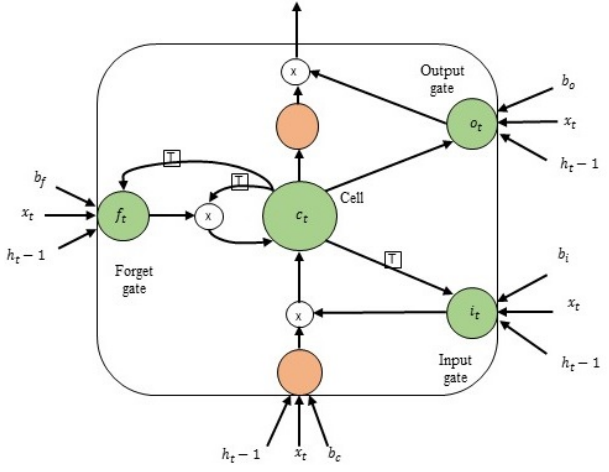
Figure 5. Structure of a memory cell in long short ‐ term memory (LSTM) ‐ RNN.